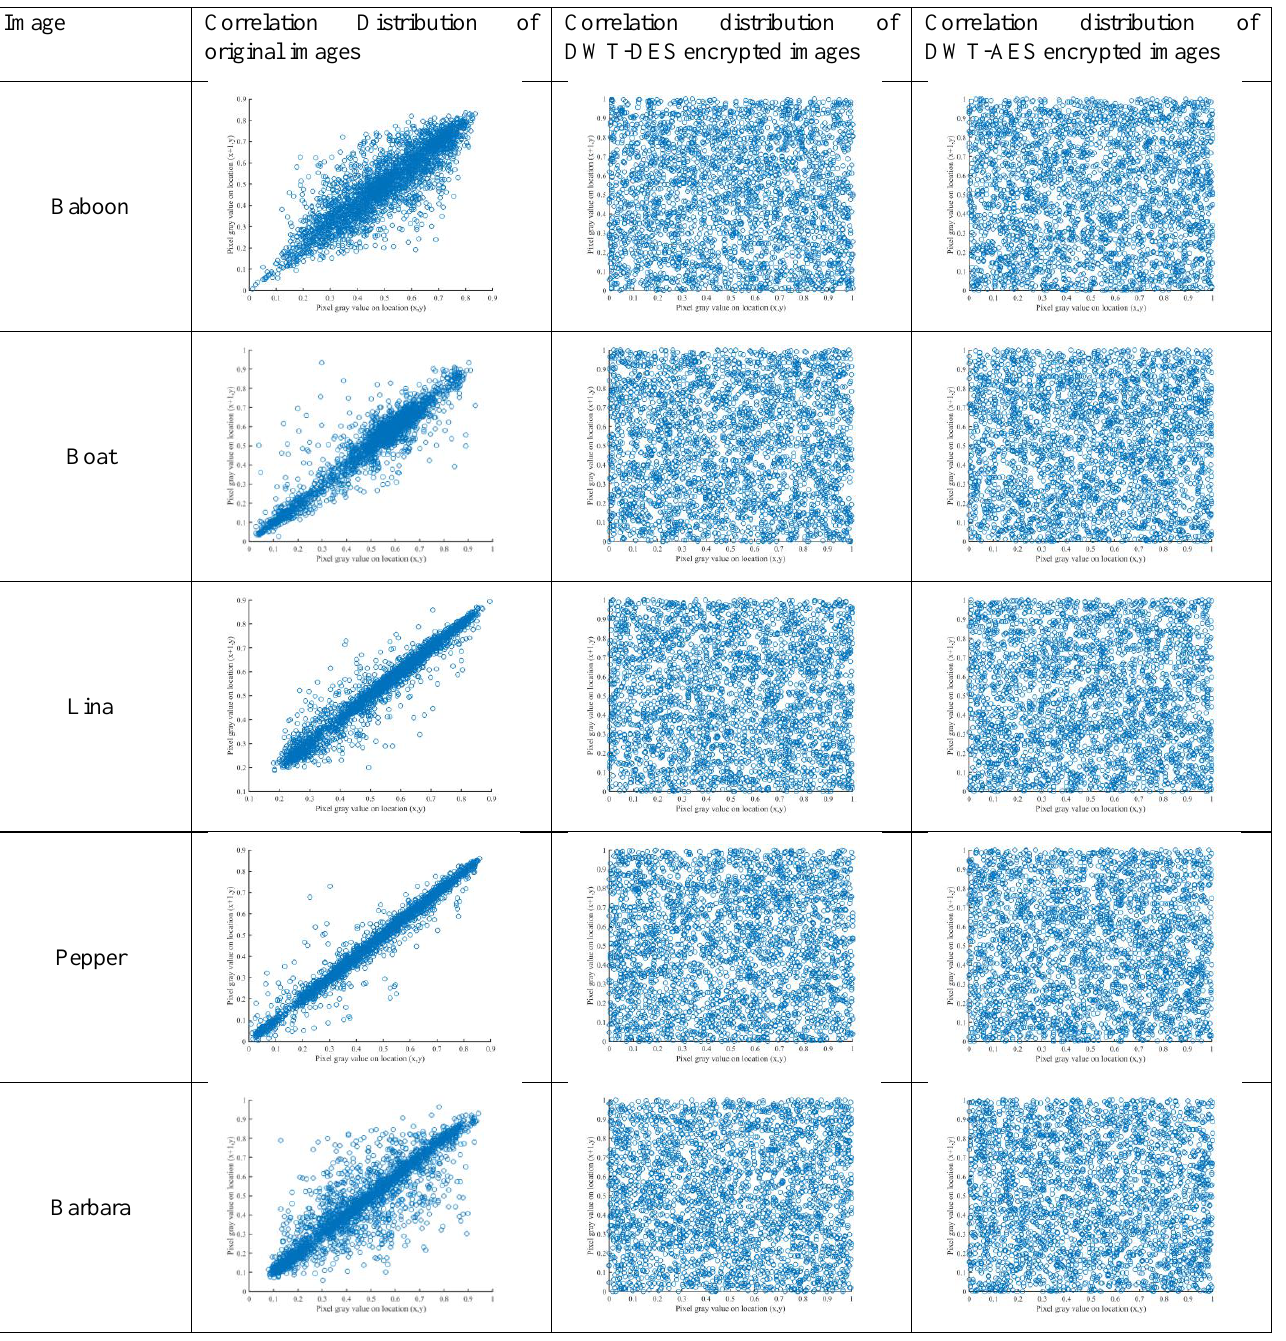
Figure 9. Correlation distributions of two horizontally adjacent pixels for five test